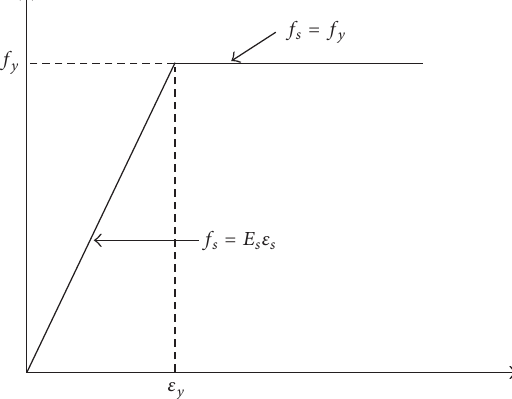
Figure 4: Constitutive model of prestressing tendon proposed by Menegotto and Pinto